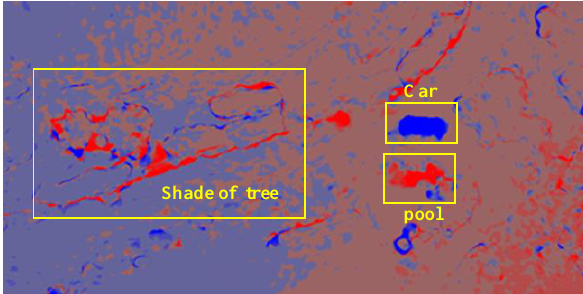
Figure 7. DSM change detection from fixed-wing UAV Quad-Rotor UAV results as shown in figure 8: the top-left map, which is vertical images with georeferenced mapping, can